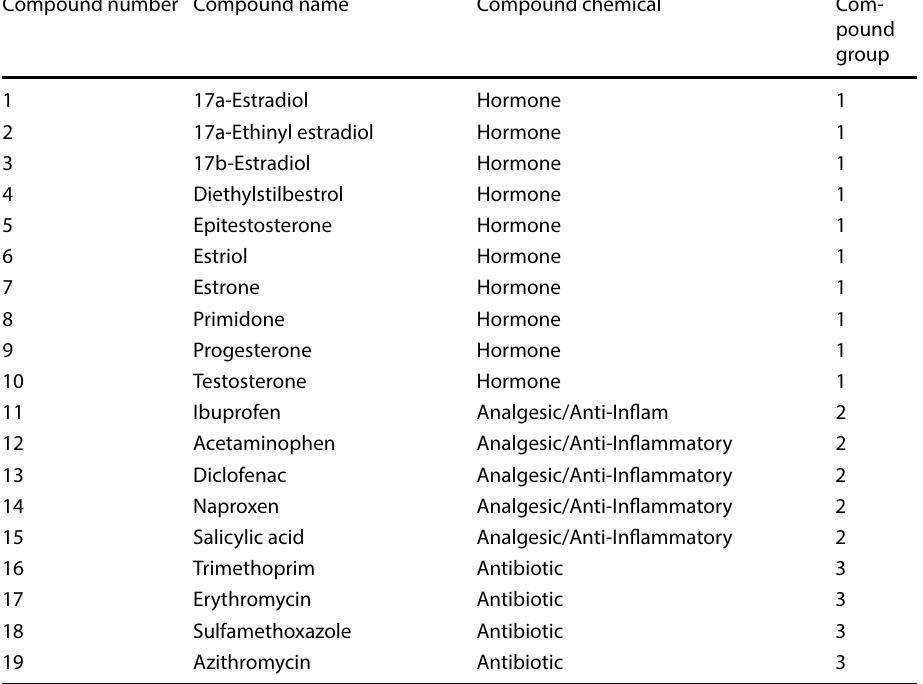
Table 1 The groups of PPCPs and compound names